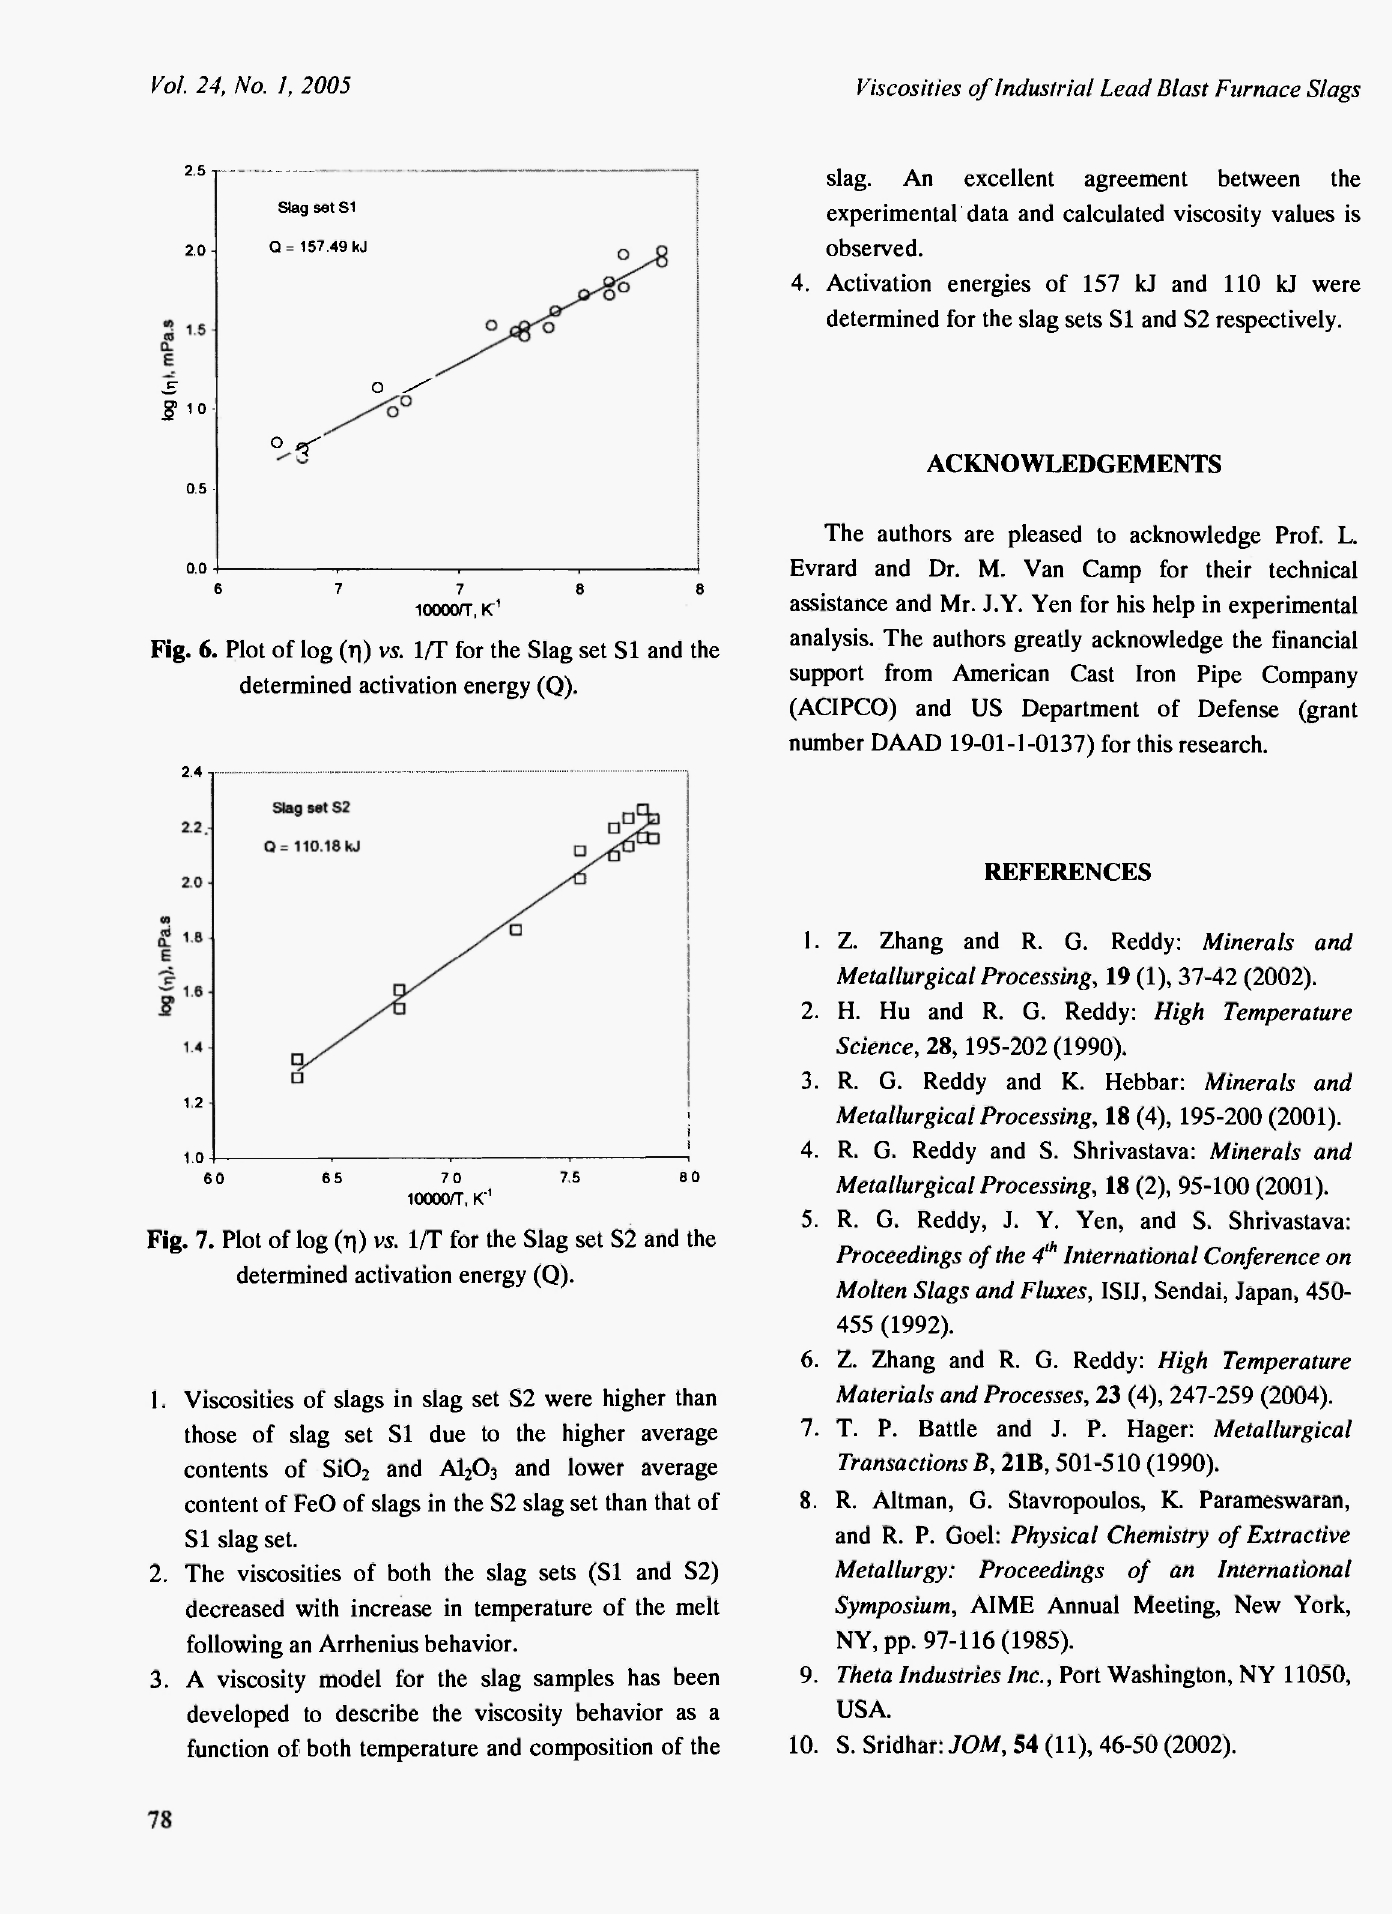
slag. An excellent agreement between the experimental· data and calculated viscosity values is observed. 4. Activation energies of 157 kJ and 110 kJ were determined for the slag sets SI and S2